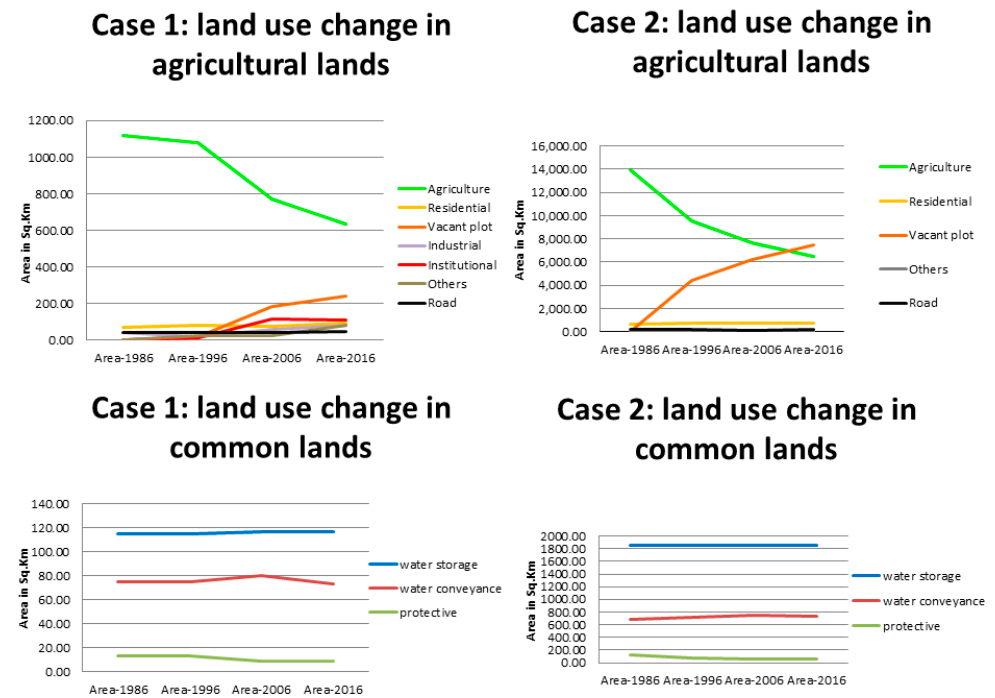
Figure 5. Trends in land use change for case 1 and case 2.